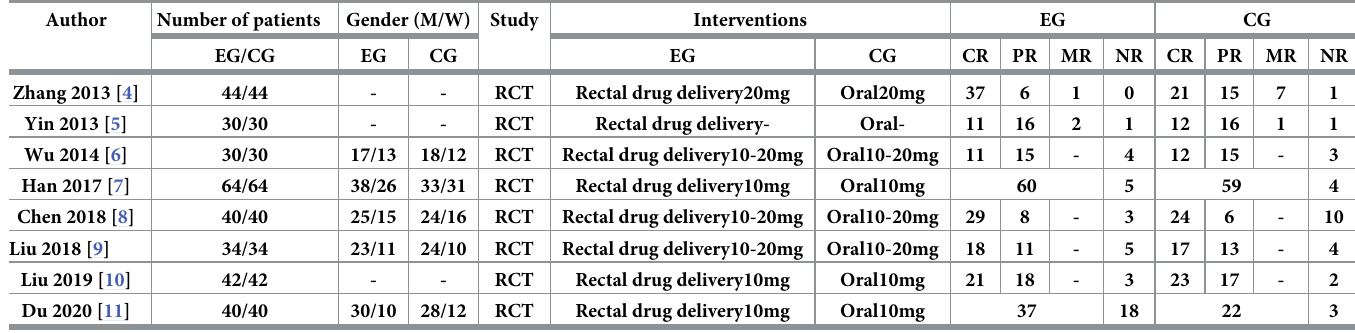
Table 3. Characteristics of the included